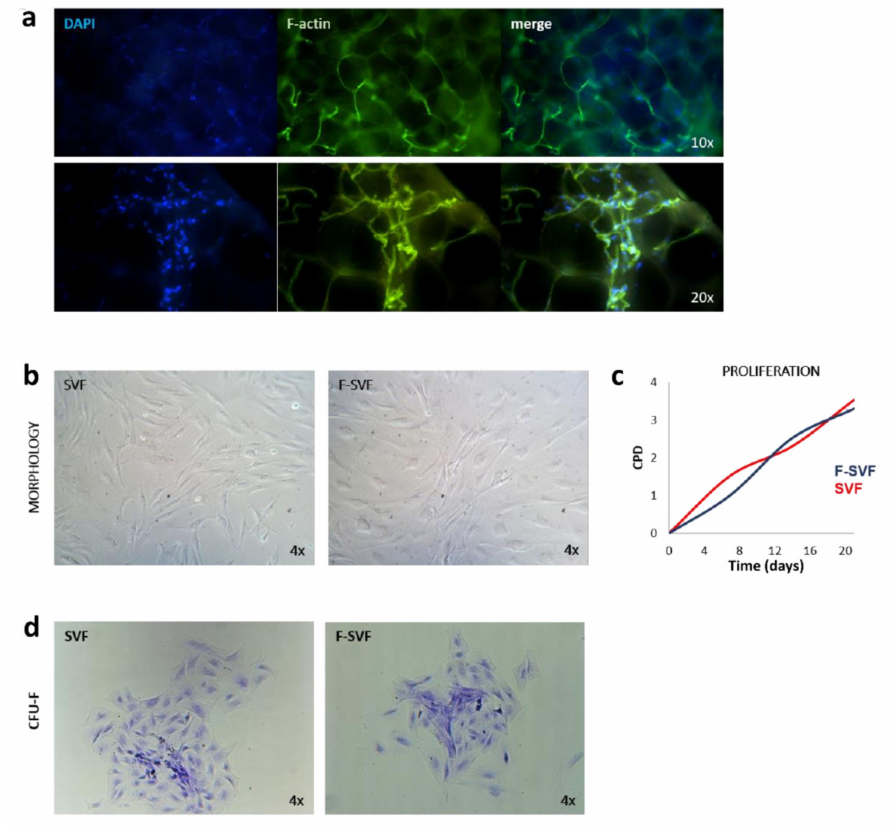
Figure 4. Adipose tissue skeleton structure was visualized by phalloidin staining: ( a ) representative images of cells derived by stromal vascular fraction (SVF) and the fraction derived vascular fraction (F-SVF). In both conditions, the cells had similar morphology to a fibroblastoid shape ( b ); the cells show the same proliferation ability by calculation of cell population doubling time ( c ); SVF and F-SVF cells demonstrated to have the same ability to form colony forming unity fibroblasts (CFU-F) ( d